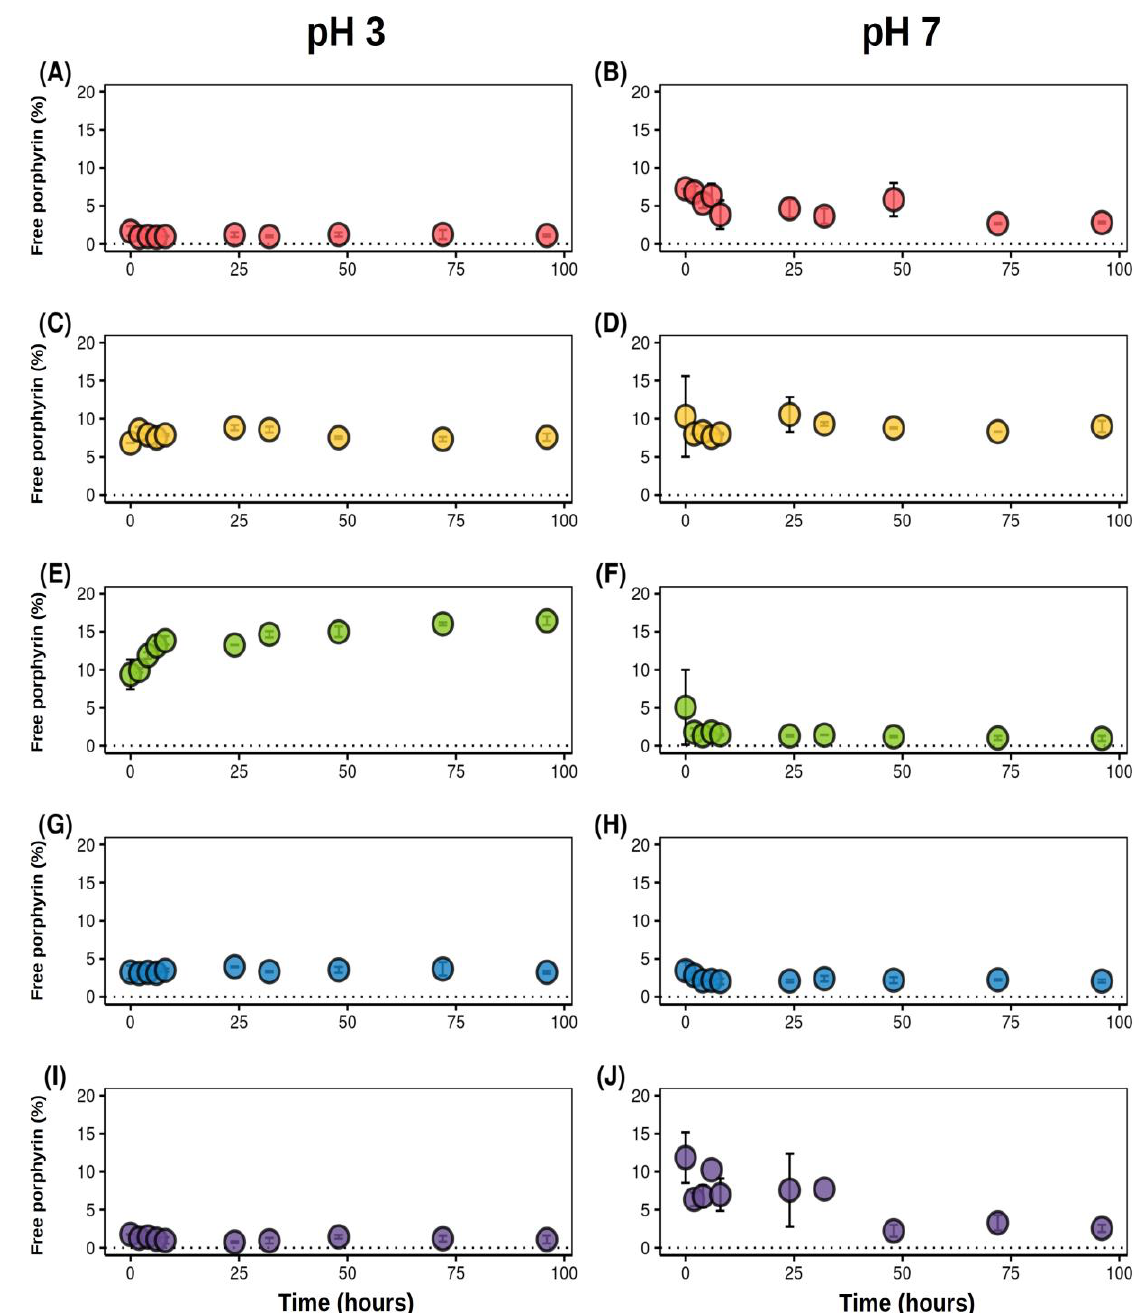
Figure 7. Leaking of porphyrins over time, as a function of pH. Porphyrin leakage was evaluated in pH 3 and pH 7 for THPP ( A,B ), T(OAc)PP ( C , D ), T(MAP)PP ( E , F ), T(PrOH)PyP ( G , H ) and ZnTHPP ( I , J ), respectively. The leakage is presented as free porphyrin, with respect to the initial amount of porphyrin, 20 µM.